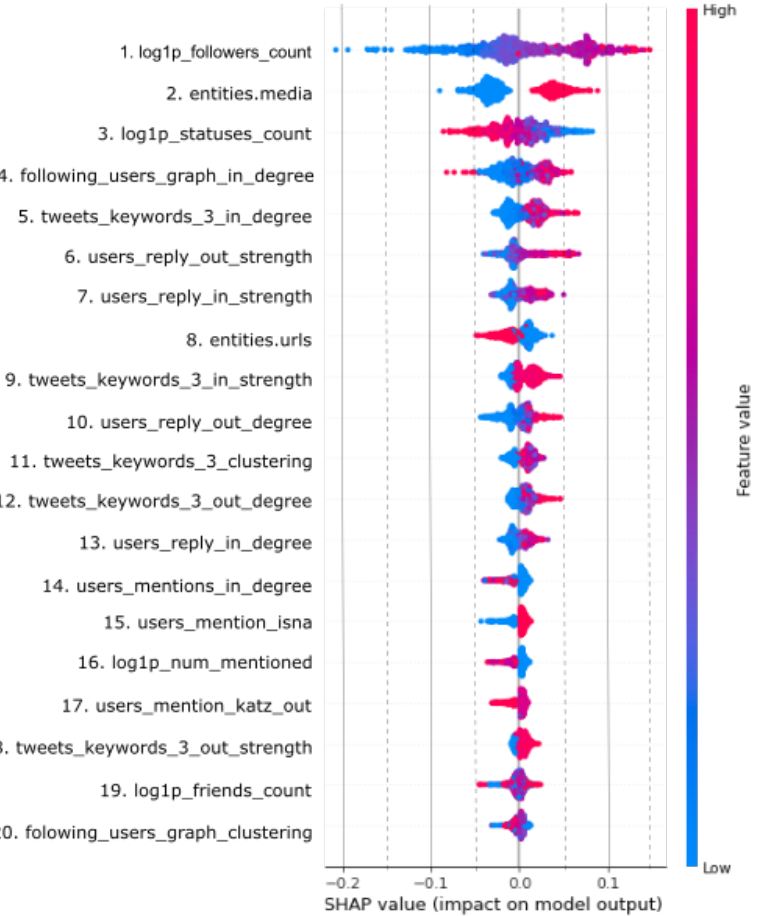
Figure 3. SHAP values analysis on bee swarm summary plot illustrating impact on model